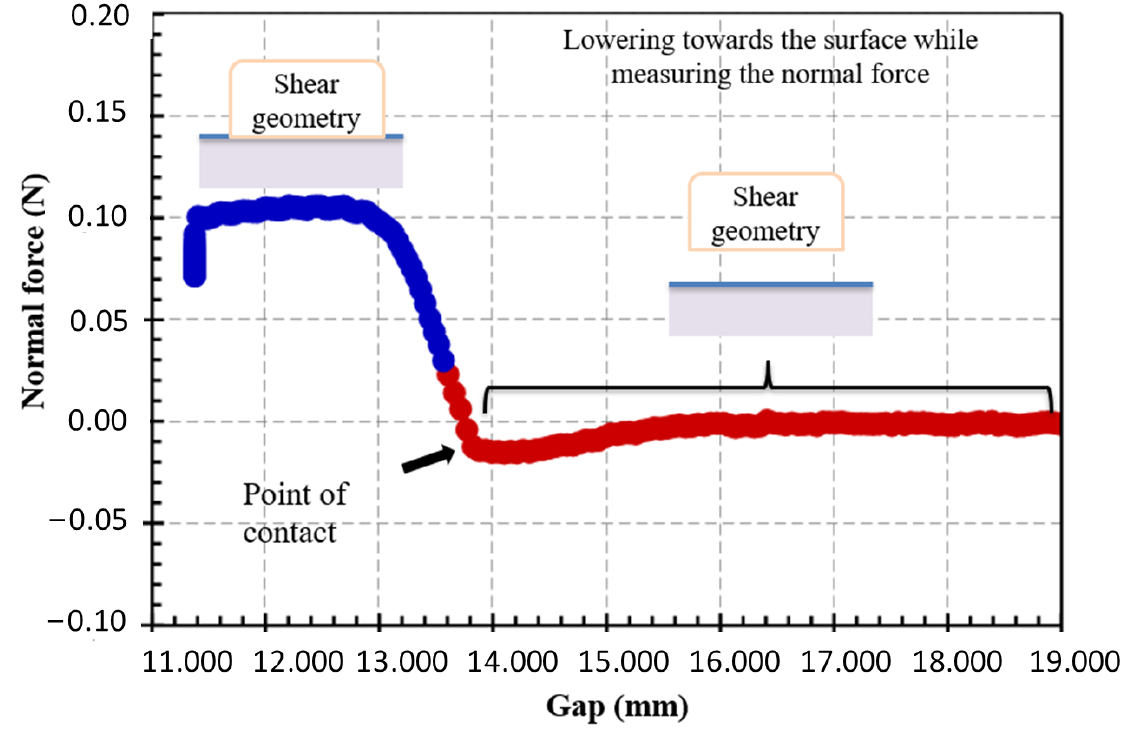
Figure 5. Positioning of the object at the interface with normal force assistance.